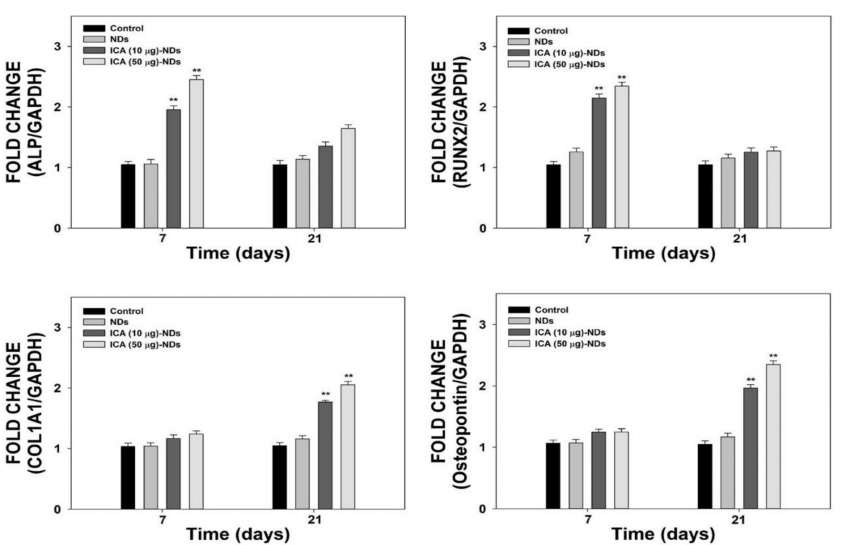
Figure 8. The mRNA levels of ALP, RUNX2, COL1A1, and OPN in cells treated with NDs, ICA (10 µ g)-NDs, and ICA (50 µ g)-NDs after 7 and 21 days of incubation ( n = 4 / group). ** p <